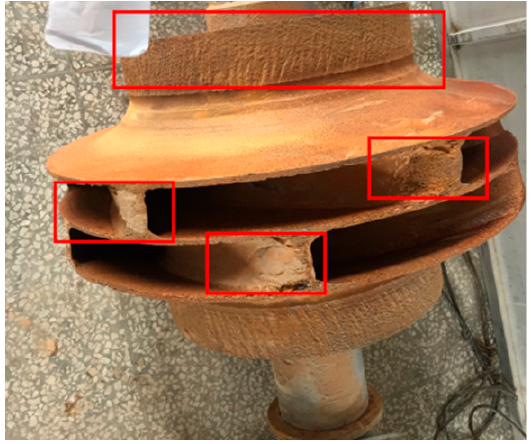
Figure 6. Physical picture of erosion.